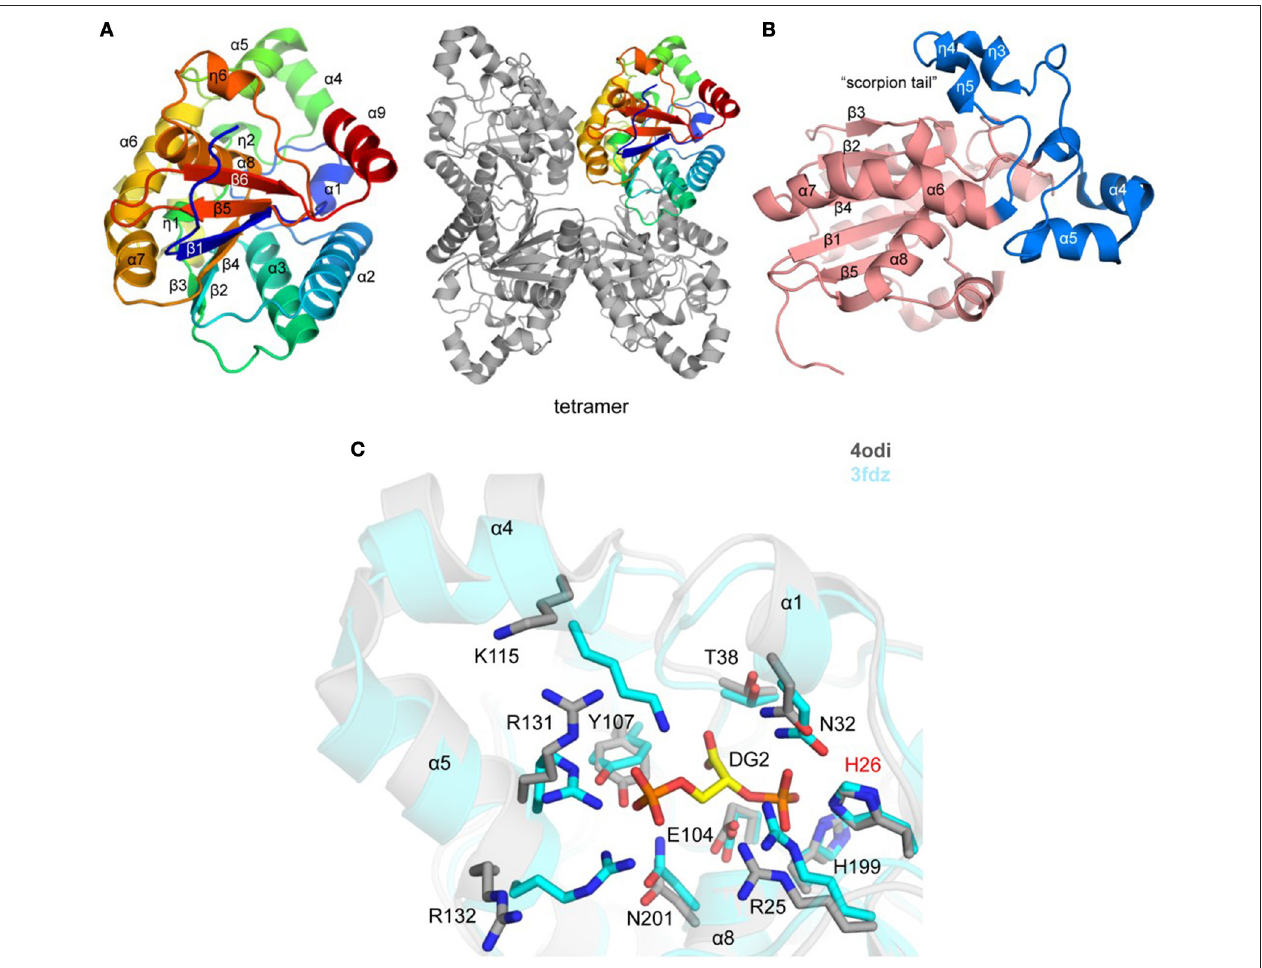
FIGURE 2 | Crystal structure of Tg PGM (A). Ribbon representation of Tg PGM monomer (left side) colored blue (N-terminus) to red (C-terminus) and tetramer of Tg PGM (right side) (B) . Domain structure of Tg PGM [red—an α / β / α -sandwich domain (residues 12–107 and 169–257) and blue—a domain without any defined folding motif (residues 108–168)] (C) . Pairwise structural alignment of Tg PGM (gray) and Bp PGM (cyan) showing active site with residues of Tg PGM shown in sticks and labeled in one-letter code. Equivalent residues of Bp PGM are displayed. Bp PGM binds (2R)-2,3-diphosphoglyceric acid, DG2, in the active